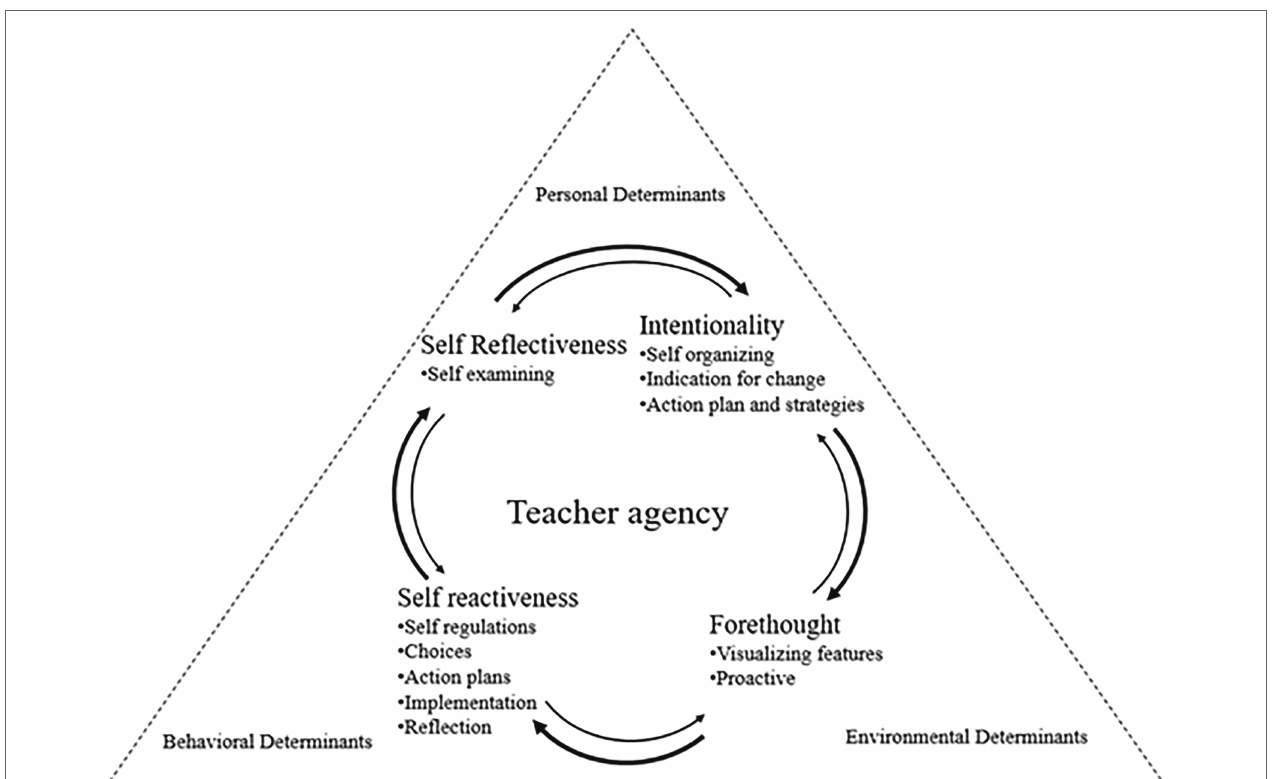
FIGURE 1 | The Triadic Reciprocity Framework Core Agency Concepts (TRFCAC) model (Jenkins, 2020, p.